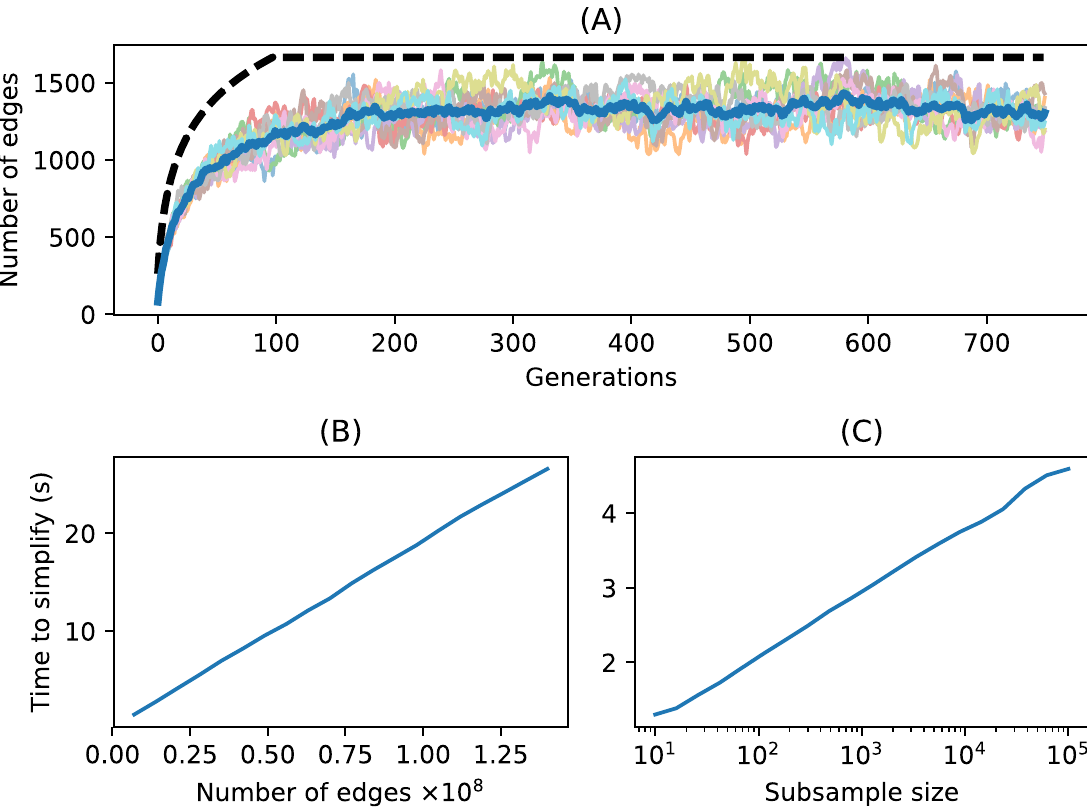
Fig 7. Time and space complexity of simplify. (A) Number of edges in the simplified tree sequence for 10 replicate Wright–Fisher simulations with N = 100 as a function of number of generations. Each line is one simulation, the heavy blue line gives the average, and the dashed line is the upper bound of Eq (1). (B) Time required to simplify the first k edges of a large (4.2GiB) unsimplified tree sequence produced by a forwards-time simulation plotted against k . The time scales linearly with the number of input edges. (C) Time required to simplify the tree sequence resulting from a coalescent simulation of 500,000 samples of a 200 megabase human chromosome to a random subsample of n samples, plotted against n (note the log scale; the time scales logarithmically with n